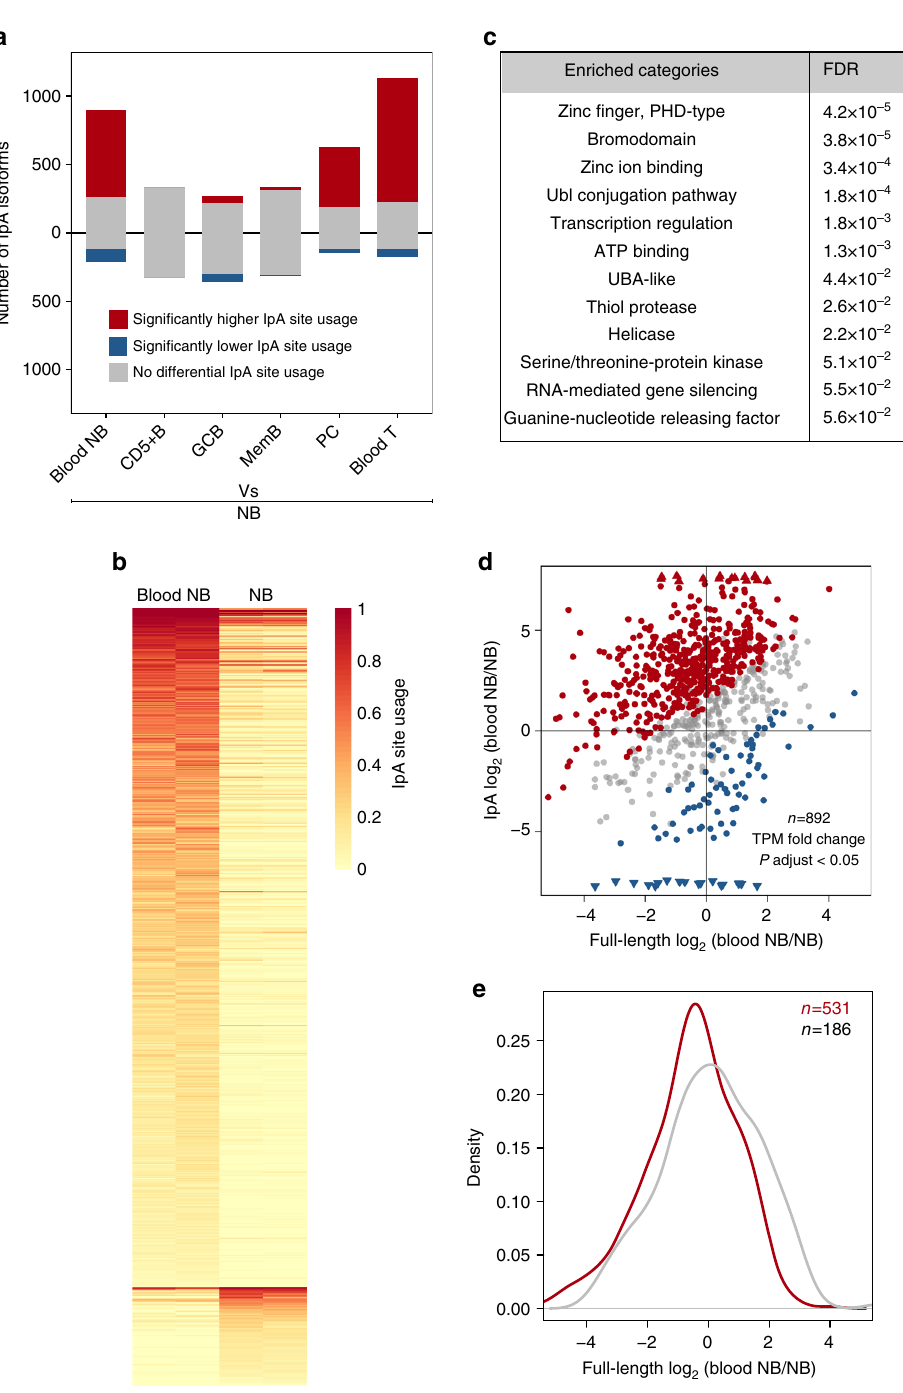
Fig. 3 Dynamic expression of IpA isoforms in immune cells. a Number of IpA isoforms with differential usage of IpA sites between NB from lymphoid tissue versus other immune cells (FDR-adjusted P < 0.05). b Heatmap showing IpA site usage of IpA isoforms with signi fi cantly different usage (FDR-adjusted P < 0.05) between NB derived from blood or lymphoid tissue ( n = 720). Each row indicates an IpA isoform. c Enrichment of gene ontology terms for the genes shown in b . d Fold change of IpA isoform and full-length mRNA expression in blood versus lymphoid tissue-derived NB by TPM. All the genes that were tested for differential usage are shown ( n = 892). If a gene had multiple IpA isoforms, then the one with the most signi fi cant differential IpA usage is shown. IpA isoforms with signi fi cantly different usage (FDR-adjusted P < 0.05) are highlighted in red (higher usage) or blue (lower usage). e Signi fi cant downregulation of full-length mRNAs in genes with signi fi cant IpA isoform expression (one-sided KS test, P < 10 − 5 ). Shown are genes highlighted in red from